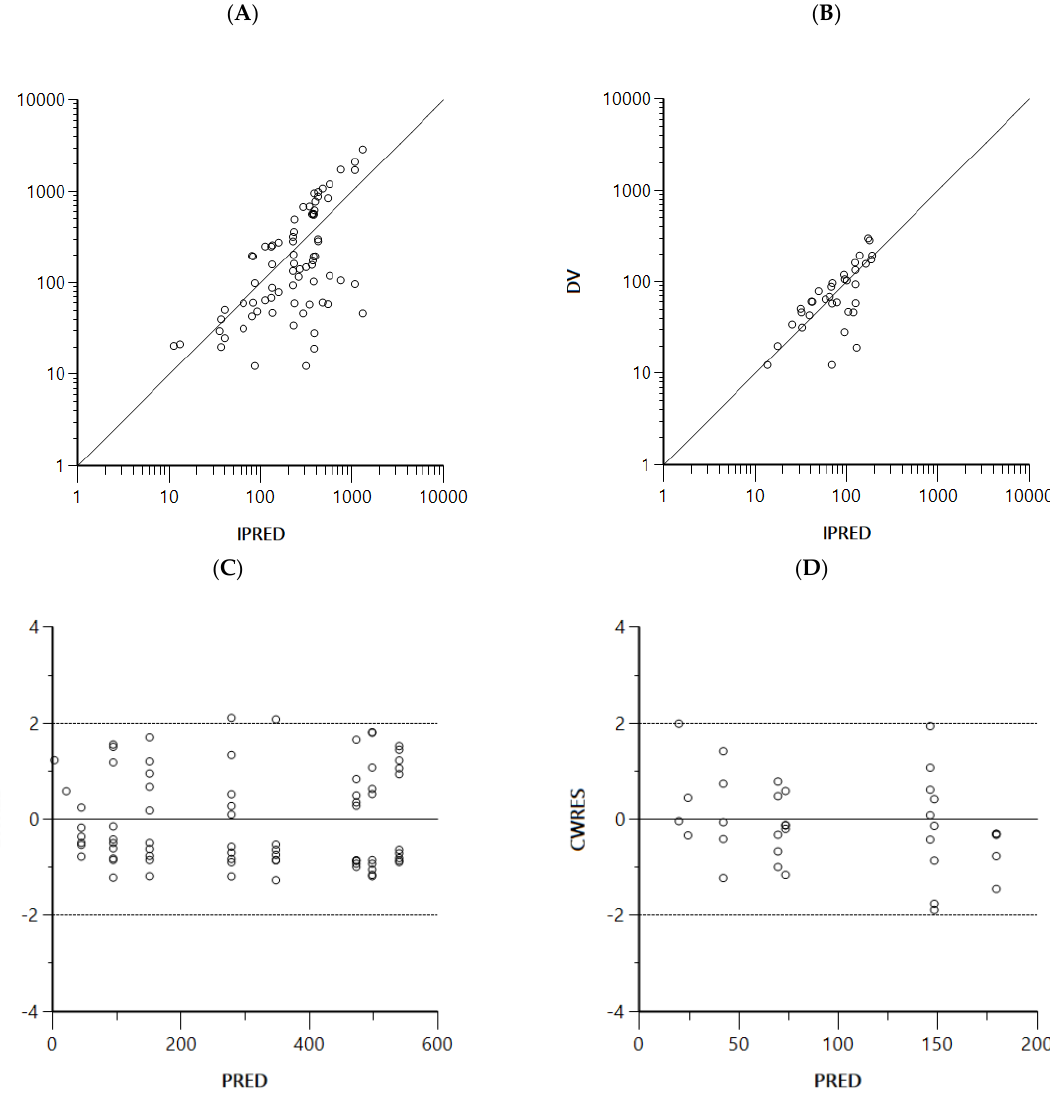
Figure 6. Goodness-of-fit plots for the final model. Observations vs. individual predicted concen- trations of ( A ) FMN and ( B ) DZN, and conditional weighted residuals (CWRES) vs. population predictions of ( C ) FMN and ( D ) DZN. Circles represent the observed values of FMN and DZN.